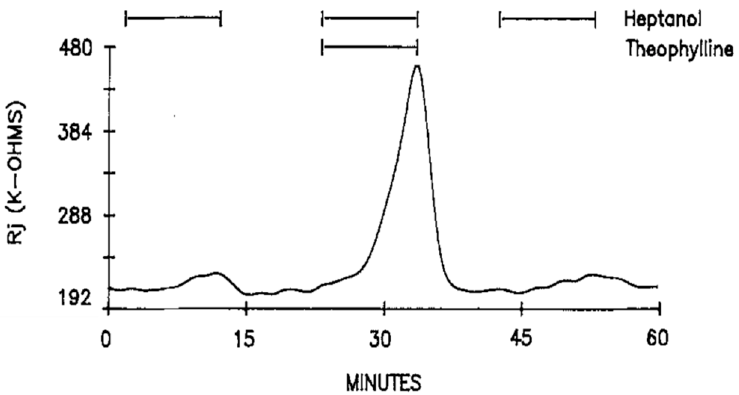
Figure 6. Time course of Rj in crayfish axons uncoupled by heptanol in the presence and absence of 20 mM theophylline. As with caffeine (Figures 2–4), theophylline dramatically increases Rj maxima with heptanol. Adapted from [16].